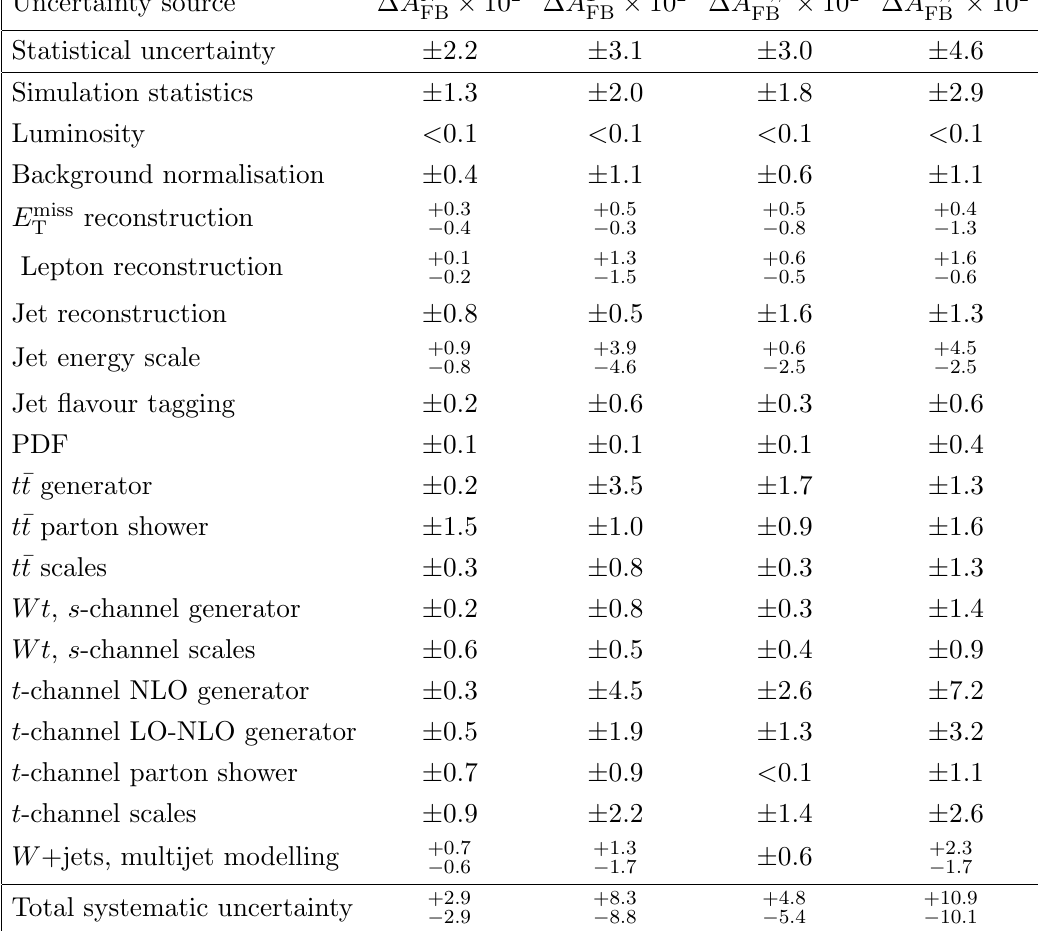
Table 5. Uncertainties contributing to the measurements of the A N metries. For better readability the uncertainties are multiplied by 10 2